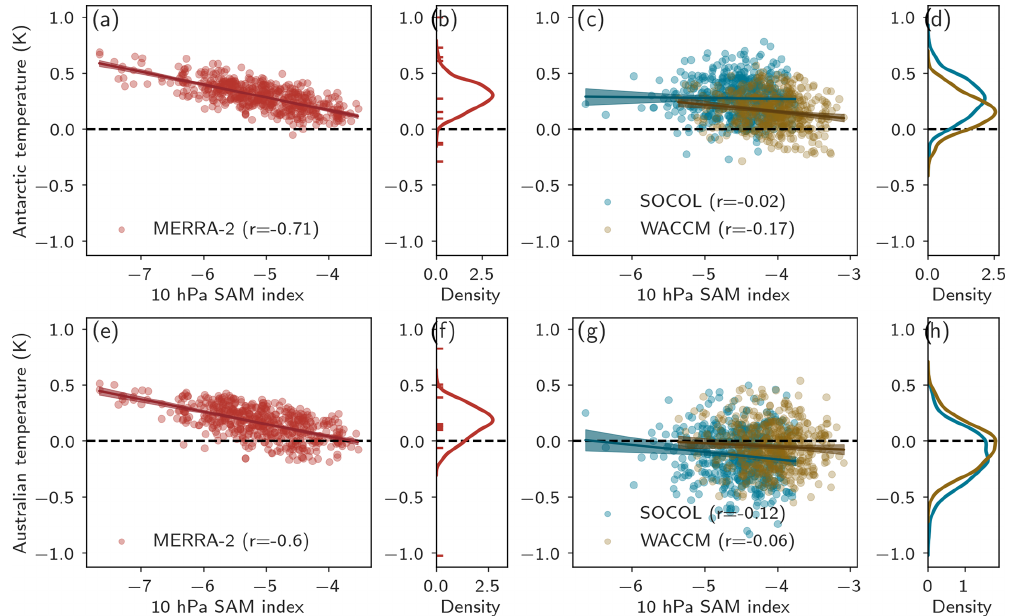
Figure 6. Scatterplots of 500 synthetic bootstrapped composites ( n = 10) for Antarctic (a, c) and Australian (e, g) 2m temperature anomalies in weak polar vortex regimes vs. the composite stratospheric 10hPa SAM peak anomaly. The r value refers to the Pearson correlation coefficient between the two quantities. The line refers to the fitted linear regression and the 95% confidence interval of the slope is shown as shading. The kernel density estimation (KDE) values of the temperature composites are shown on the right of the scatterplots (b, d, f, h) , and the mean 2m temperature values for the 10 weak polar vortex regimes are marked with red dashes for the reanalysis datasets.